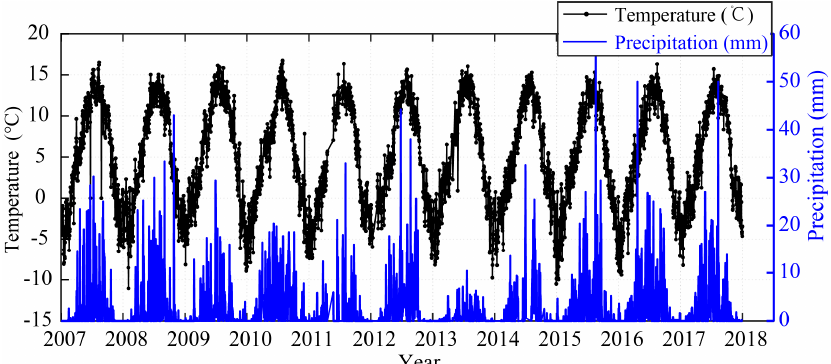
Figure 6. Daily values of 1.2–1.5 m air temperature (black dots), precipitation at 3326 m elevation (blue right axis). Data Source: http://www.tpedatabase.cn. (Station Location: Longitude: 94°44 ′ 18 ″ ; Latitude: 29°45 ′ 56 ″ ).